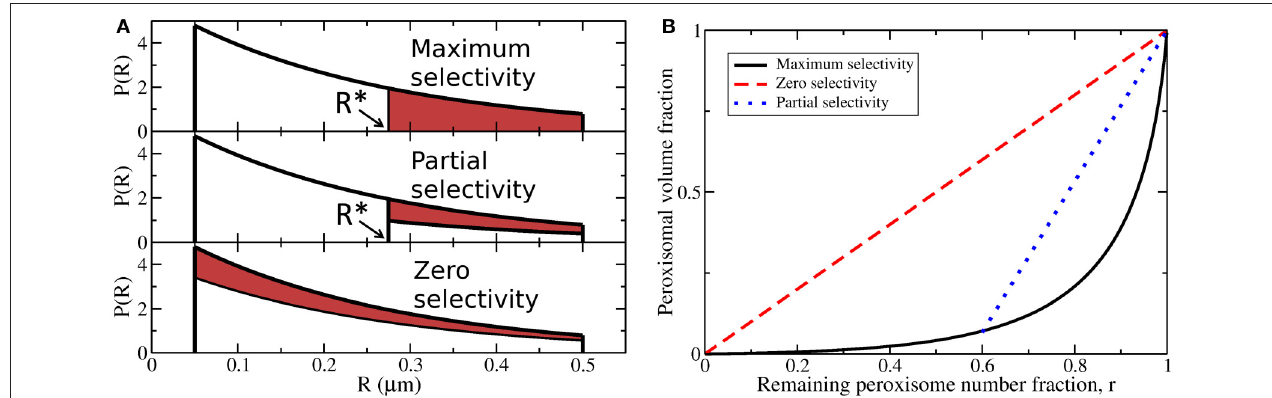
FIGURE 3 | (A) Maximum size selectivity in pexophagy is achieved when all of the largest peroxisomes, of radius R > R ∗ , are degraded (shaded red area) from a distribution of peroxisome sizes (solid black line, illustrating an exponential distribution of abundance P ( R ) vs. radius R ). Partial size selectivity is achieved when a fraction p of the larger peroxisomes, with R > R * , are degraded. Zero size selectivity is achieved when peroxisomes are randomly chosen for degradation, independent of size. (B) The remaining peroxisomal volume fraction vs. the remaining number fraction r , after various amounts of zero selectivity degradation (dashed diagonal red line) or maximal selectivity degradation (solid black line, given by Equation 16). Partial selectivity is equivalent to maximum selectivity a fraction p of the time, and so lies on a line interpolating between maximum selectivity with the same R * and no autophagy (at r 1). One such interpolating line (dotted blue) is =